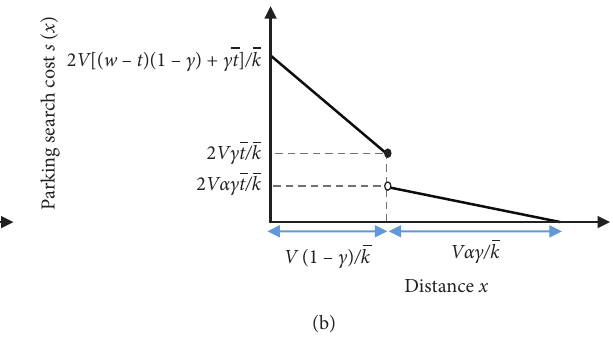
Figure 4: (a) Parking capacity Lagrange multiplier and (b) parking search cost.